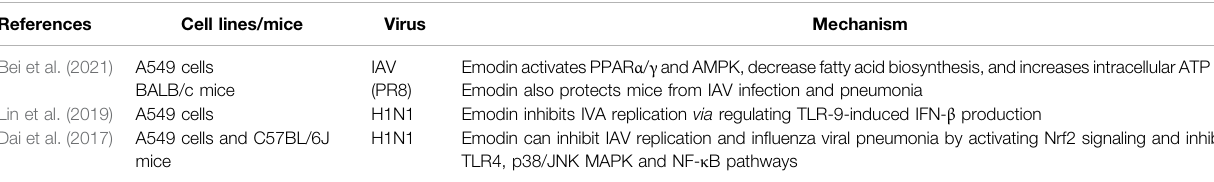
TABLE 6 | Anti-IVA activities of emodin.